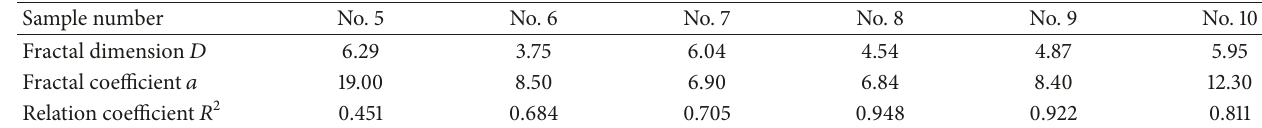
Table 5: The pore channel distribution and fractal dimensions.